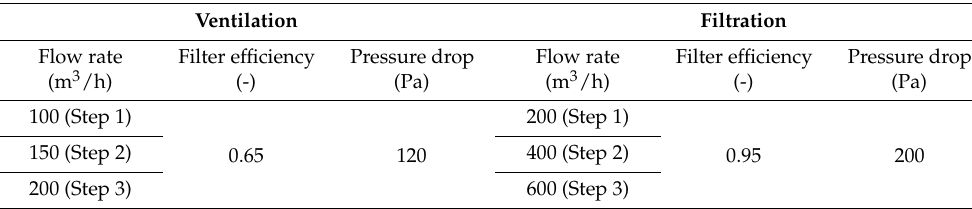
Table 6. Parameters associated with the system.